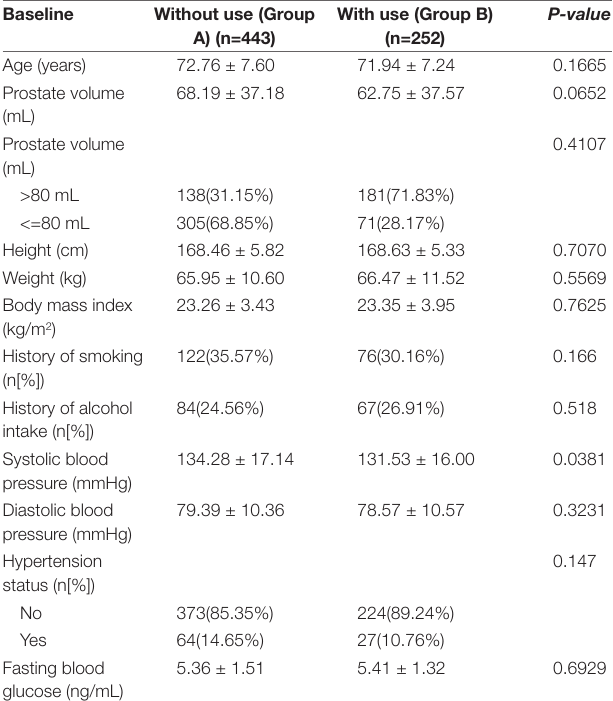
TABle 1 | Baseline characteristics of benign prostatic hyperplasia patients not use and use Hemocoagulase Bothrops Atrox for inject. Baseline Without use (group A)